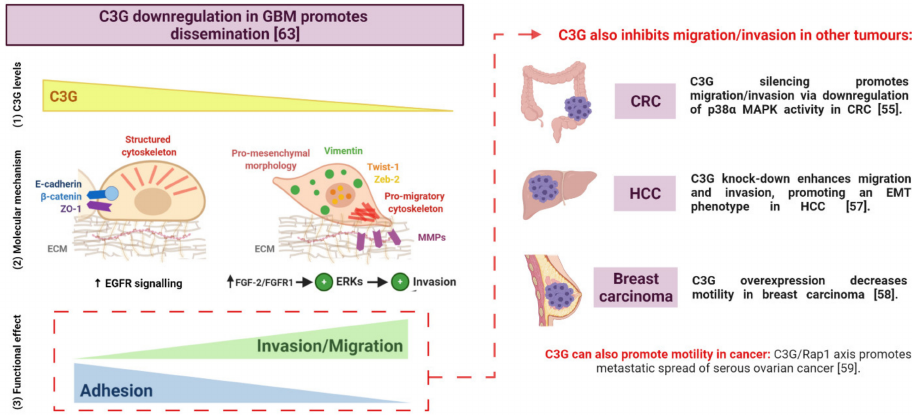
Figure 2. Role of C3G in GBM cells dissemination as compared to other tumour types . (1) C3G levels are high in healthy brain and they decrease along GBM progression [63]. (2) C3G knock- down enhances migration/invasion of GBM cells in a similar way that it does in other tumours [63]. Nevertheless, the mechanisms governing this pro-invasive effect are diverse. In GBM, ERKs are overactivated when C3G is downregulated, likely induced by the increased activation of FGF2- FGFR1 and other RTKs, which enhances invasion (left panel). (3) C3G is also a negative regulator of migration/invasion in other tumours, but not in all cancer types (right panel) [55,57,58]. In GBM, C3G is downregulated and this plays an important role enhancing tumour aggressiveness [63]. GBM: glioblastoma; CRC: colorectal carcinoma; HCC: hepatocellular